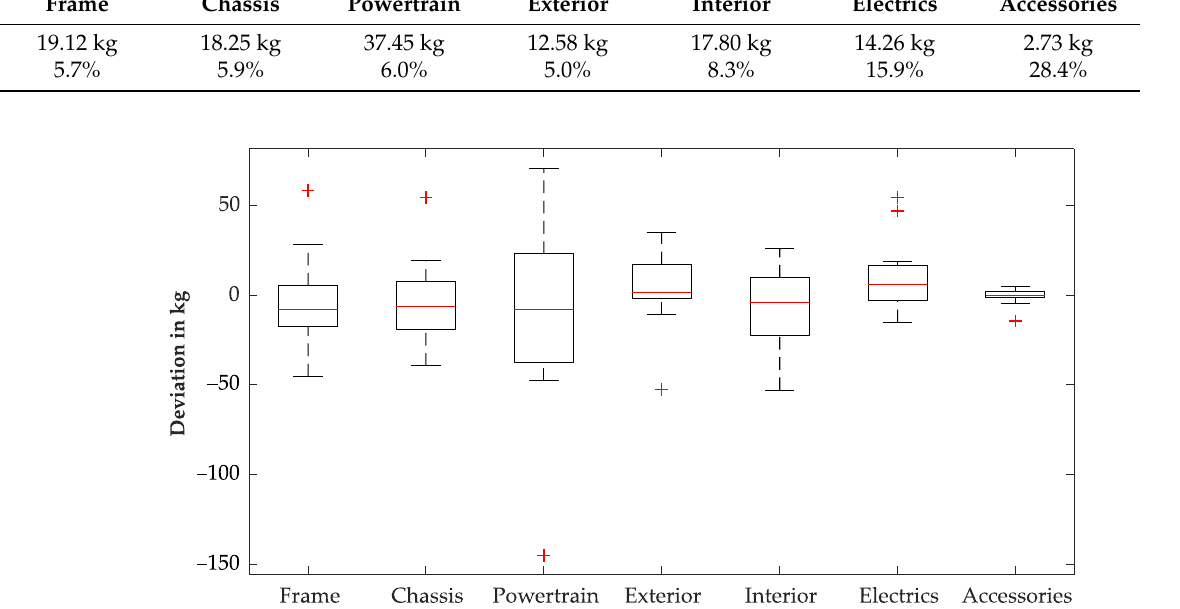
Table 3. Overview of the MAE and nMAE for the different modules.